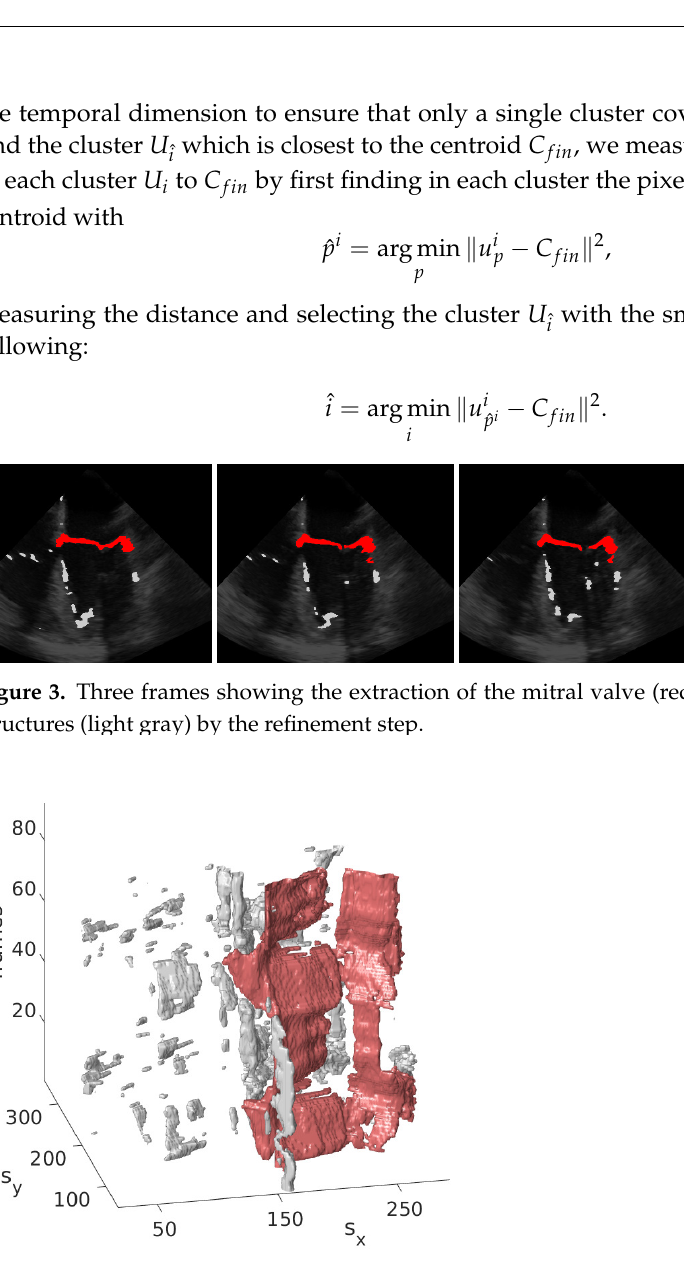
Figure 4. Three-dimensional view of the mitral valve (red), detected by the refinement